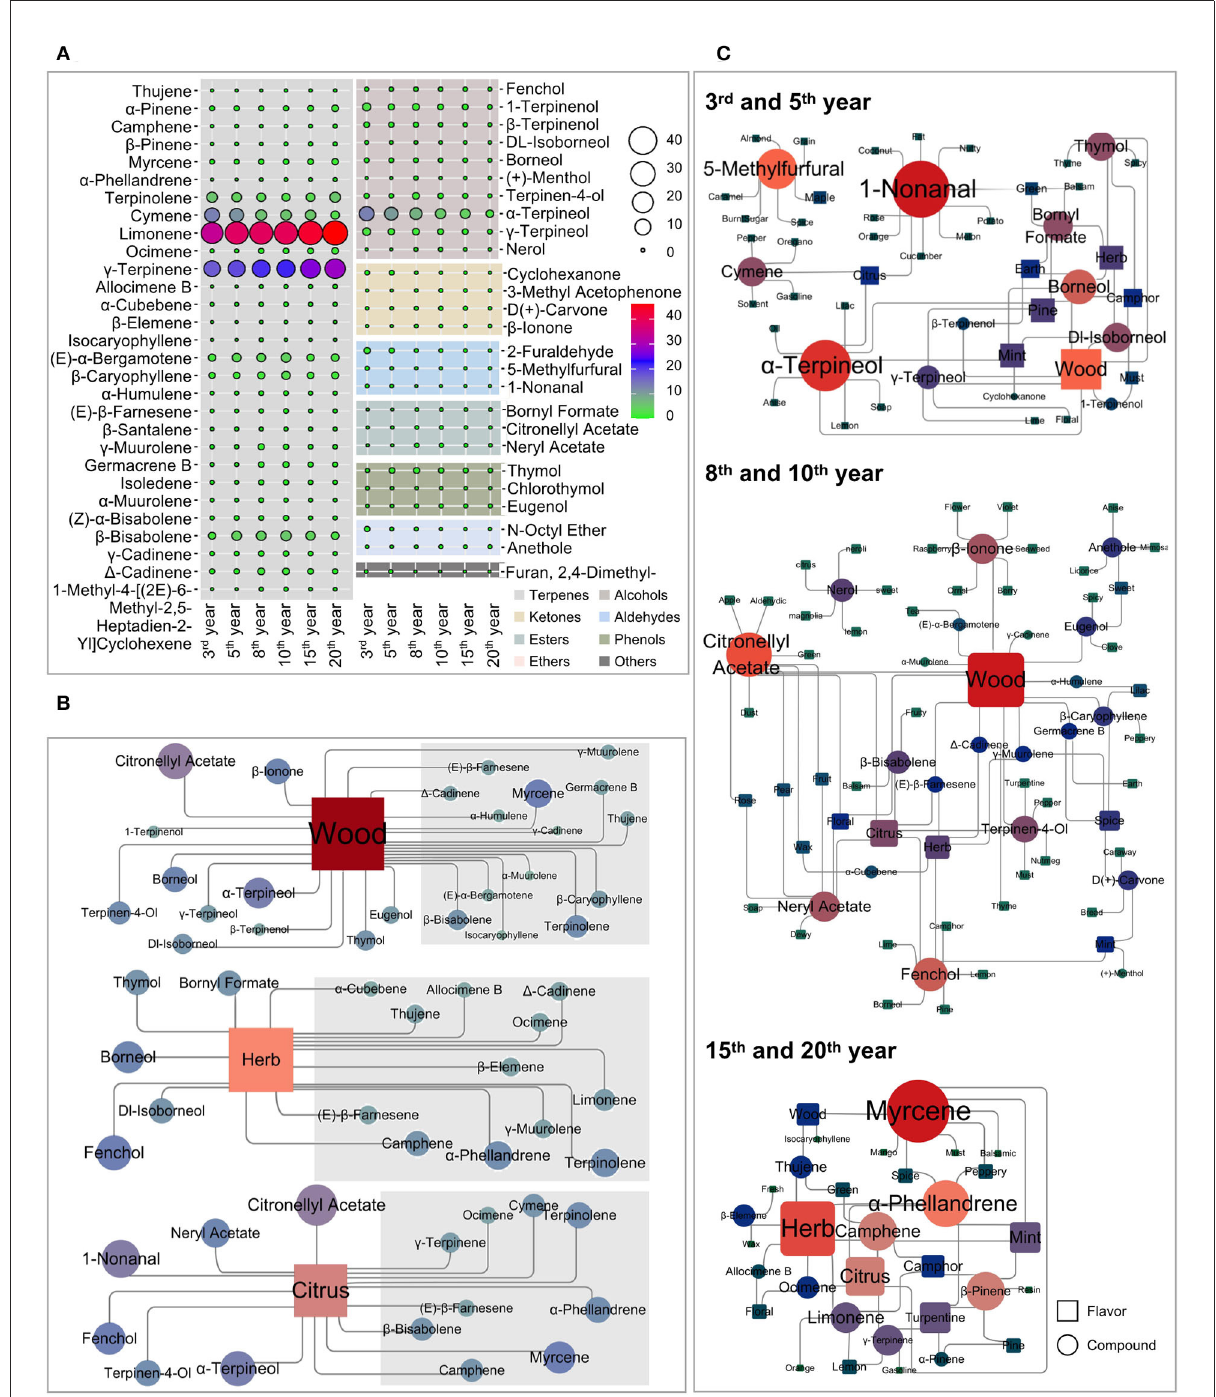
FIGURE5 Flavor correlation diagram of volatile compounds of Laoxianghuang. (A) Comparison of the composition of fermented Laoxianghuang from different years. (B) Network diagram of the characteristic flavor and related volatiles of Laoxianghuang. (C) Network diagram of the relationship between the flavor and composition of Laoxianghuang in different fermentation years. Square indicates flavor, circle indicates volatiles, and the size indicates its correlation. The redder the color, the more correlates there are; bluercolor indicates the